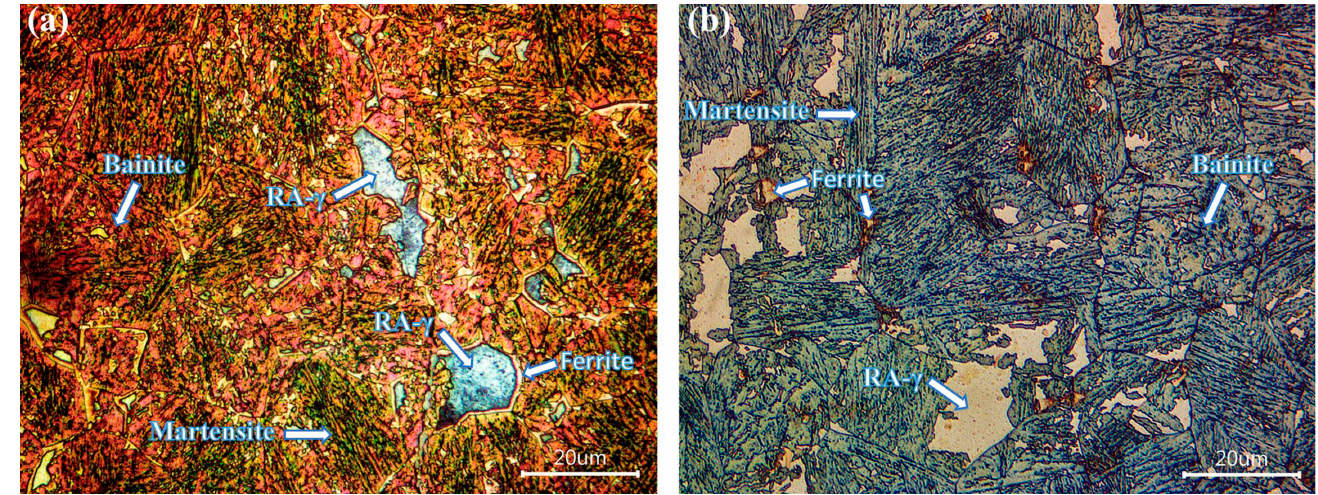
Figure 12. Q&P microstructure of ( a ) boron-containing steel given the partitioning treatment P1 (CP-Q&P-B0-P1) and ( b ) boron-containing steel given the partitioning treatment P2 (CP-Q&P-B60-P2). Optical microscope micrographs.